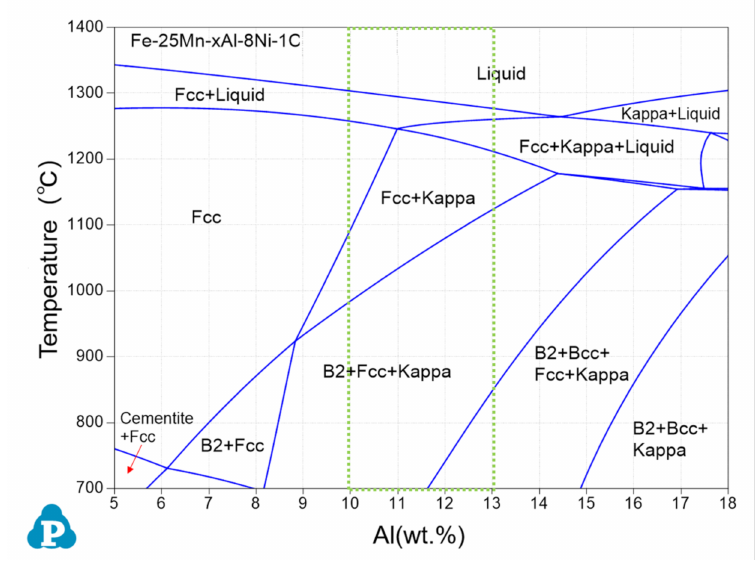
Figure 7. Binary phase diagram of Fe-25Mn- x Al-8Ni-C